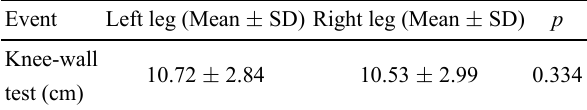
Table 4. Results of the knee-to-wall test (n =